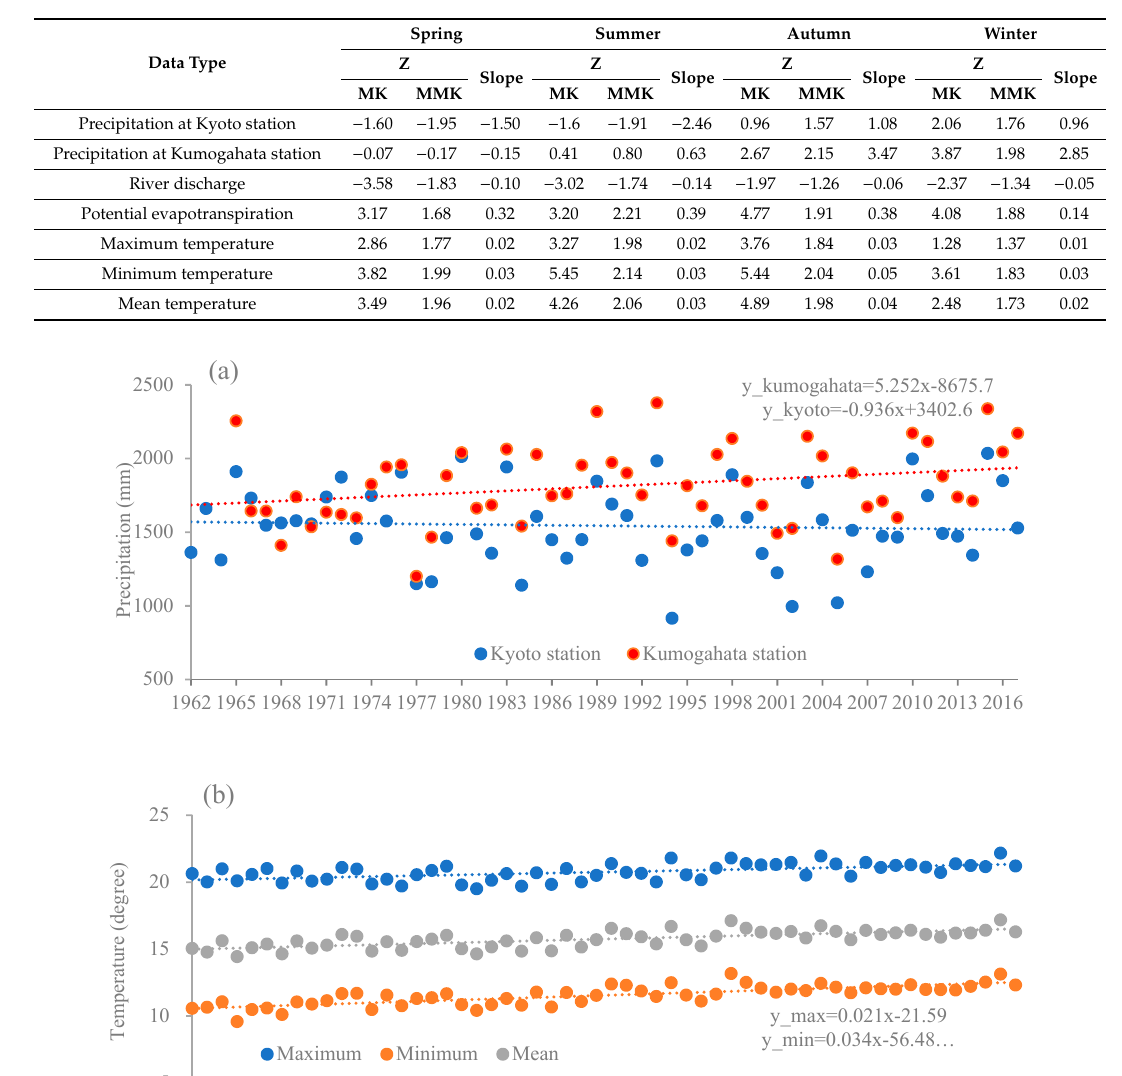
Table 2. Results of trend analysis in annual hydroclimatic variables from 1962 to 2017.